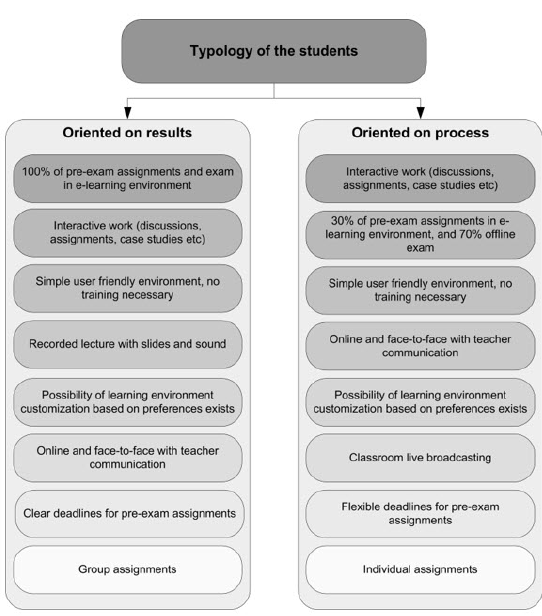
Figure 3. Typology of students based on their learning